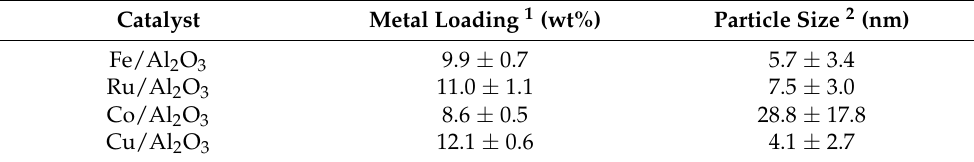
Table 2. Metal loading and average size of the particles for the different Al 2 O 3 -supported